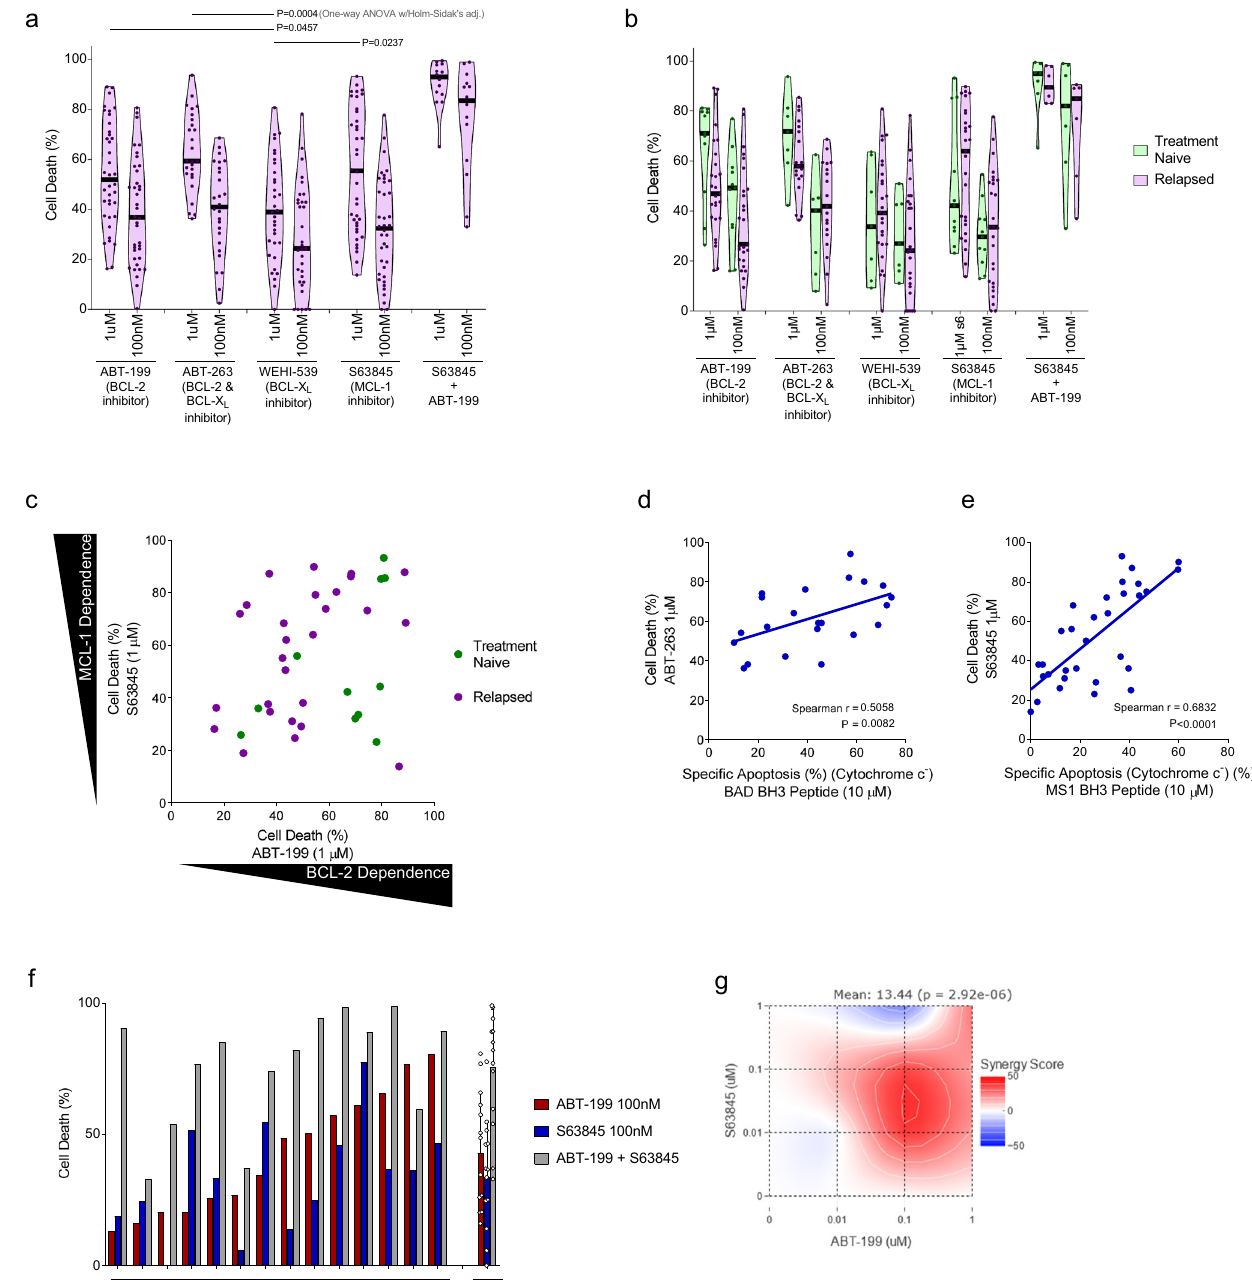
Fig. 2 | Plasma cells from patients diagnosed with AL amyloidosis undergo apoptosis in response to BH3 mimetics targeting BCL-2, MCL-1, and BCL-X L . BH3 pro fi ling correlates with ex vivo sensitivity to speci fi c BH3 mimetics. a Plasma cells were isolated from patient bone marrow aspirates, cultured ex vivo, andtreatedwithBH3mimetics.CelldeathwasmeasuredbythelossofCD138 + cells after 24h. b Patient samples were strati fi ed into treatment naïve or relapsed sub- groups according to their treatment status at the time of collection. Patients ’ apoptoticresponsetoBH3mimeticsindicated. c ComparisonofBCL-2dependence (apoptosis induced by ABT-199) versus MCL-1 dependence (apoptosis induced by S63845) across 31 patients that were not being treated at the time of sample col- lection. d – e The strength of correlation between clonal plasma cells ’ apoptotic